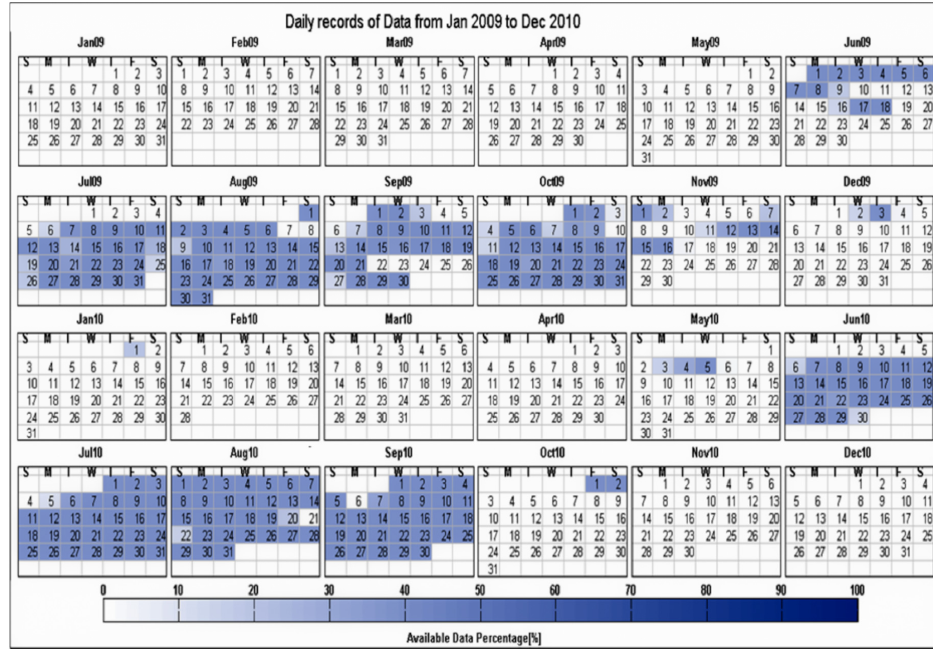
Figure 6. Calendar view of data availability: two years of operation, one system with 15 data points.